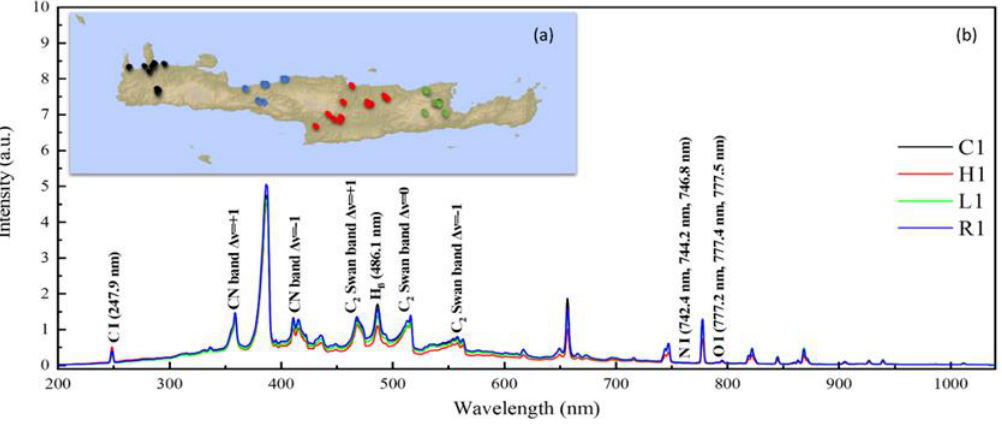
Figure 1. ( a ) Geographical distribution of the studied olive oils, ( b ) LIBS spectra of 4 representative samples, i.e., samples C1, H1, L1 and R1.